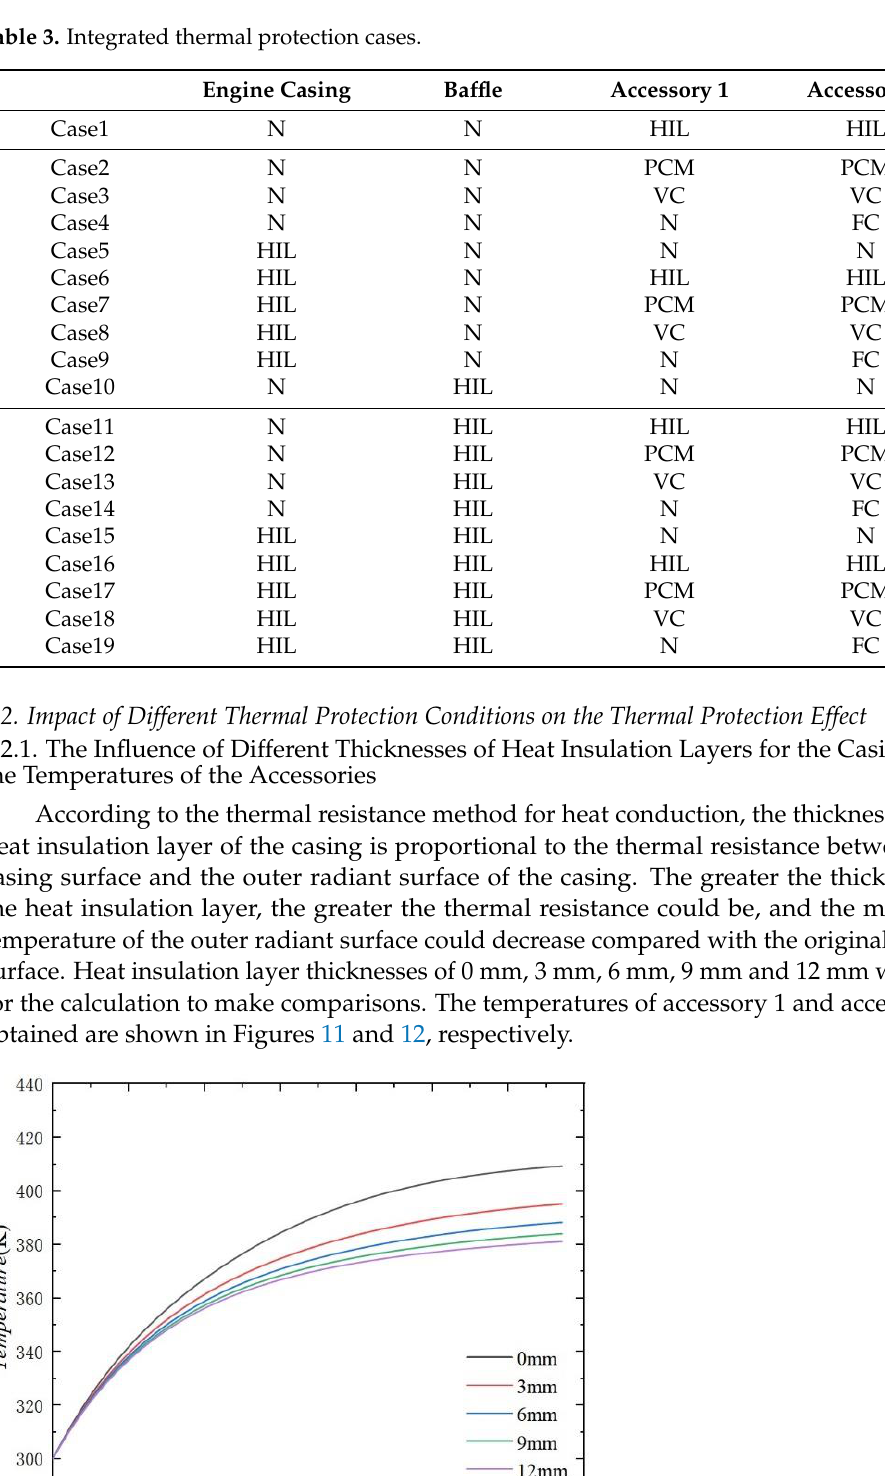
Figure 12. Temperature of accessory 2 when adding heat insulation layers of different thicknesses to the casing. As can be seen from Figures 11 and 12, the greater the insulating layer thickness, the better the heat insulation effect, but for accessory 1 with an internal heat source, when adding an equal thickness of the heat insulation layer, the accessory temperature drop was significantly less than accessory 2 with no inner heat source. For example, adding a 3 mm heat insulation layer caused the final temperature of accessory 1 to fall by 20 K, and the final temperature of accessory 2 was reduced by about 100 K. Meanwhile, it was found that with the further thickness increase in the heat insulation layer, the descent rate of the accessory temperature reduced. For example, for accessory 2, when the insulation layer thickness increased from 0 mm to 3 mm, the final accessory temperature decreased by 100 K, and when the thickness increased from 3 mm to 6 mm, the accessory temperature de- creased only by 40 K. According to the final temperature with each thickness, the heat insulation layer of 5 mm was chosen in the integrated thermal protection measures.